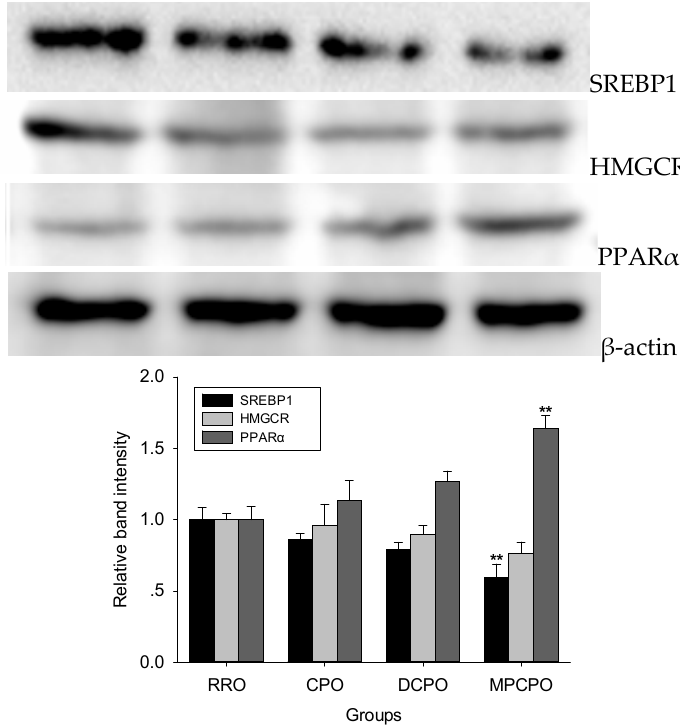
Figure 3. Effects of optimized rapeseed oils (OROs) on hepatic lipids synthesis related proteins expression. Representative immunoblot comparing relative levels of sterol regulatory element-binding transcription factor 1 (SREBP1), 3-hydroxy-3-methylglutaryl-CoA reductase